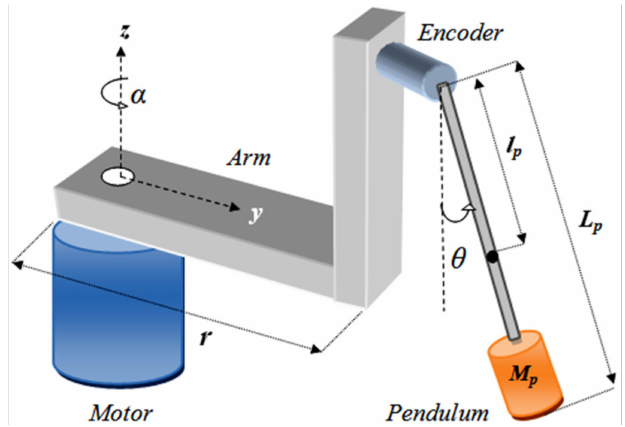
Figure 1. Simplified schematic of the SRIP system.